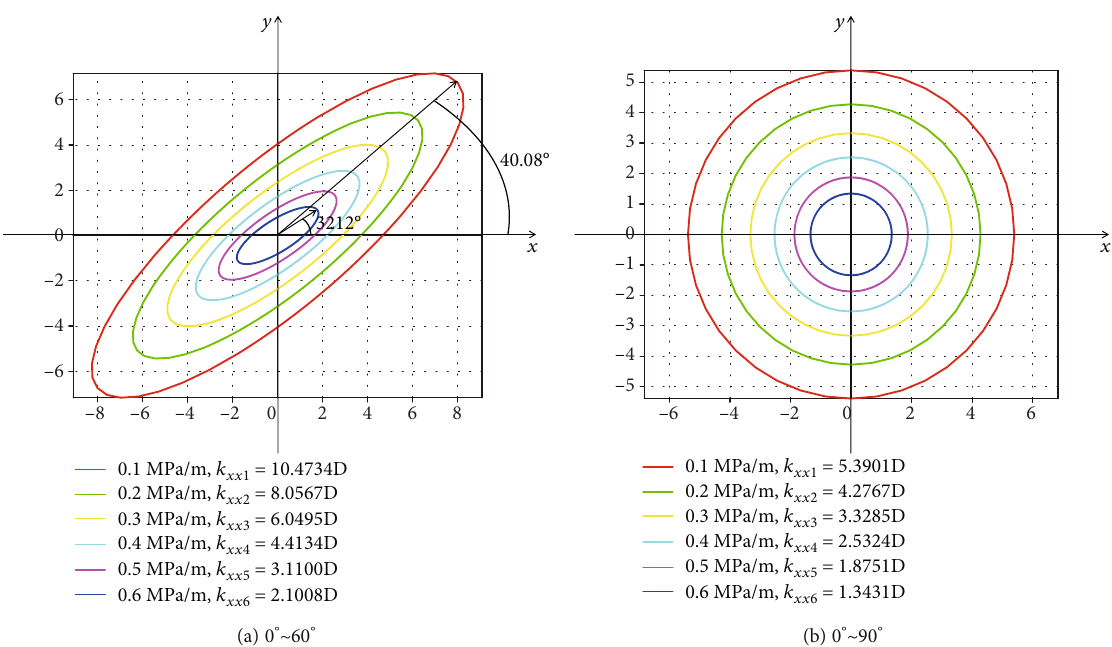
Figure 22: Variation of main values of fracture permeability for two groups at di ff erent